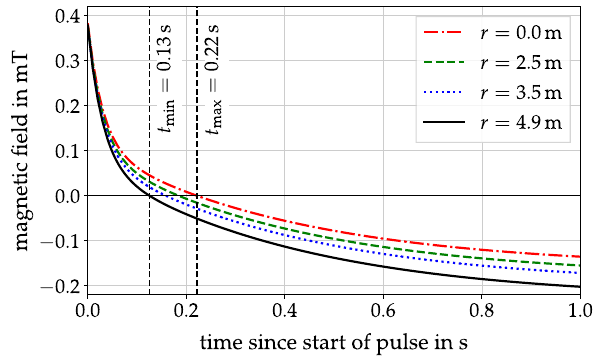
Fig. 8 Simulated magnetic field during a magnetic pulse. The plot shows the value of B z ( r , t ) from Eq. (12) in the analyzing plane ( z = 0) for different radii r . The dashed vertical lines indicate the minimal and maximal time ˆ t min , max when the field reaches zero. Due to the radial inhomogeneity of the magnetic field, this time is shorter for higher radii and minimal at the vessel radius r max = 4 . 9